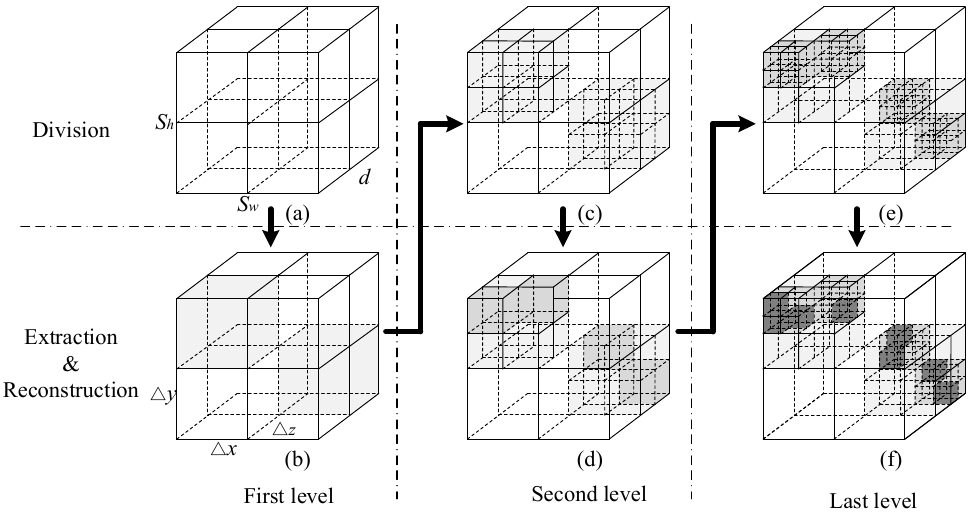
Figure 6. Basic process of three-level imaging. Figure 6a,b present the basic process of the first-level division, extraction and reconstruction.